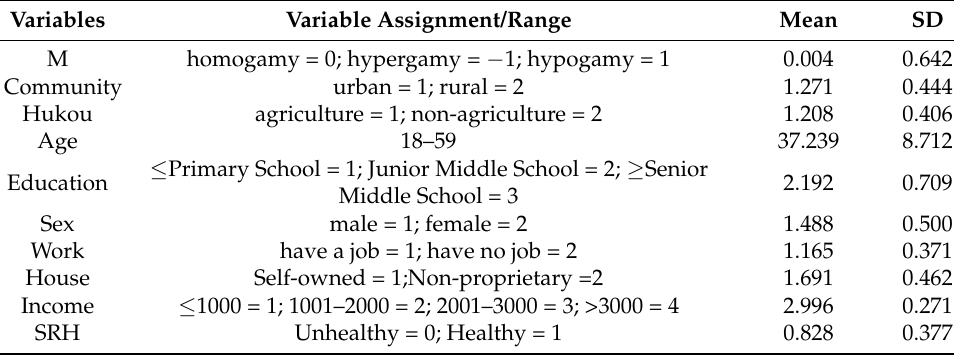
Table 1. Definition and Statistical Description of Major Variables (N =